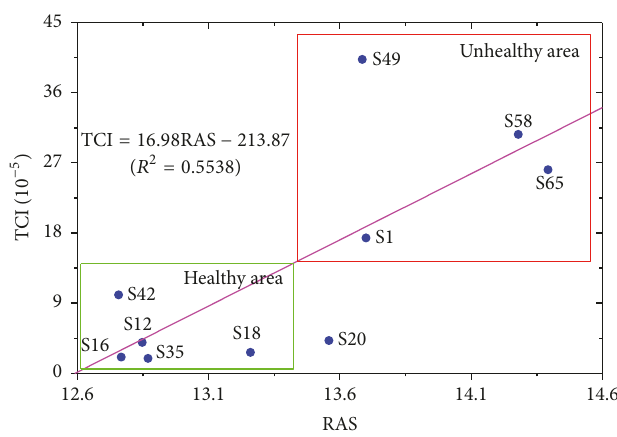
Figure 9: The correlation between the crack index and the vibration